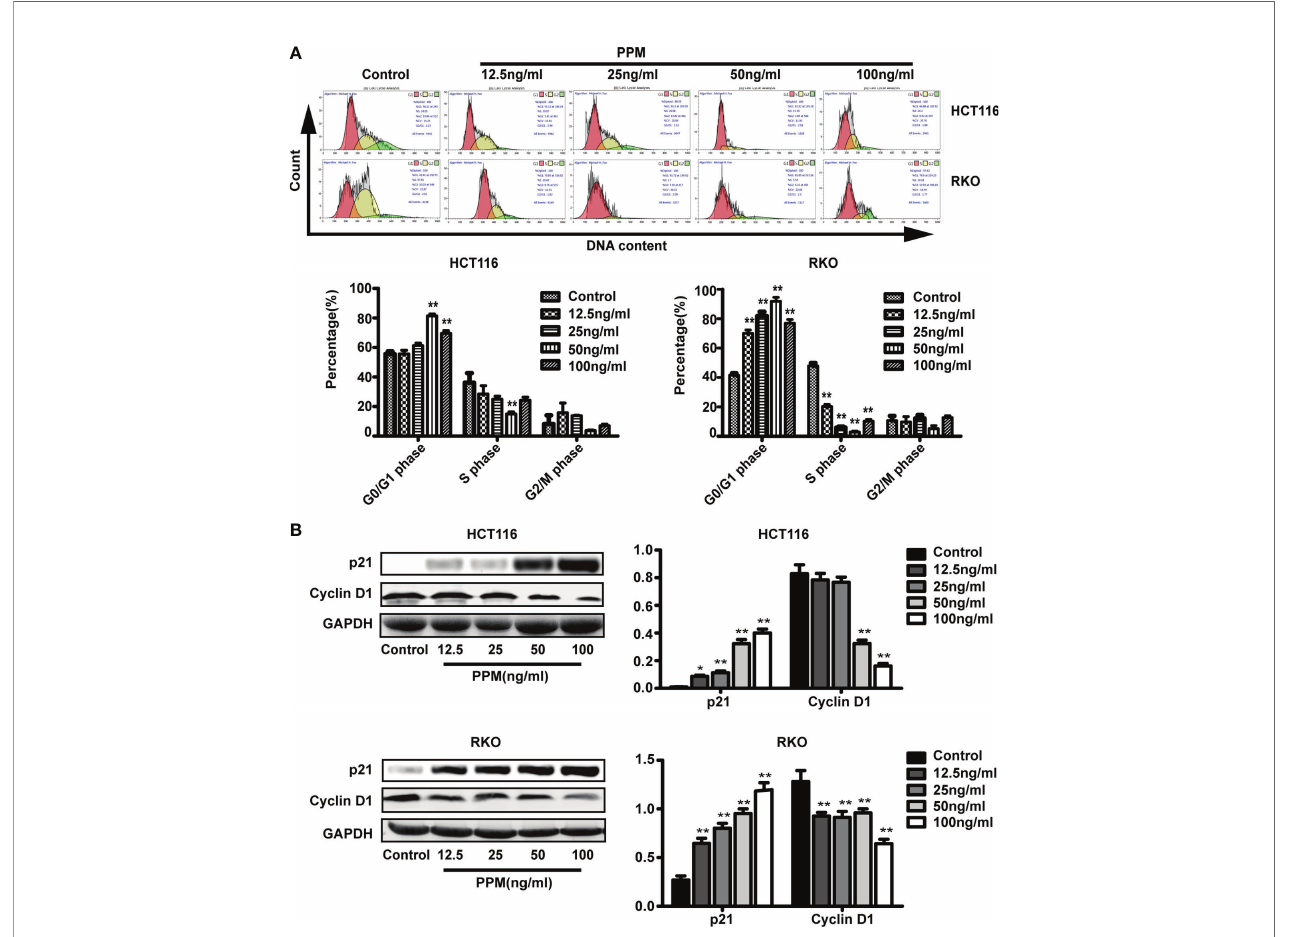
FIGURE 4 | Periplocymarin (PPM) induces cell cycle arrest in colorectal cancer cells. (A) PPM induced G0/G1 cell cycle arrest in HCT 116 and RKO cells as determined by fl ow cytometry. (B) The protein expression of cyclin D1 was decreased and that of P21was increased with PPM treatment. Values are shown as means ± SEM. * P < 0.05, ** P < 0.01, vs . untreated control